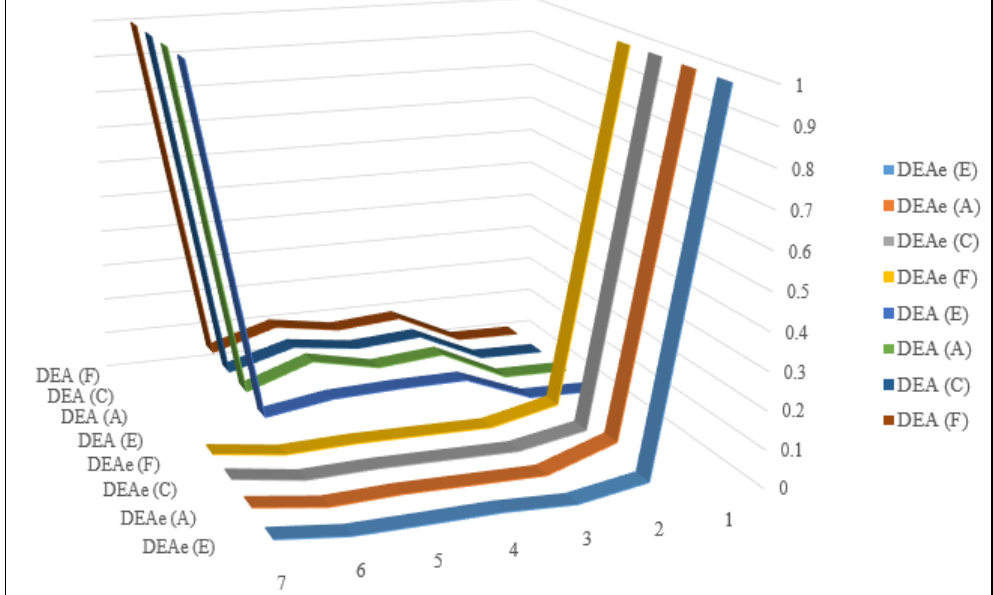
Figure 9: The comparison of DEA scores in financial and environmental issues